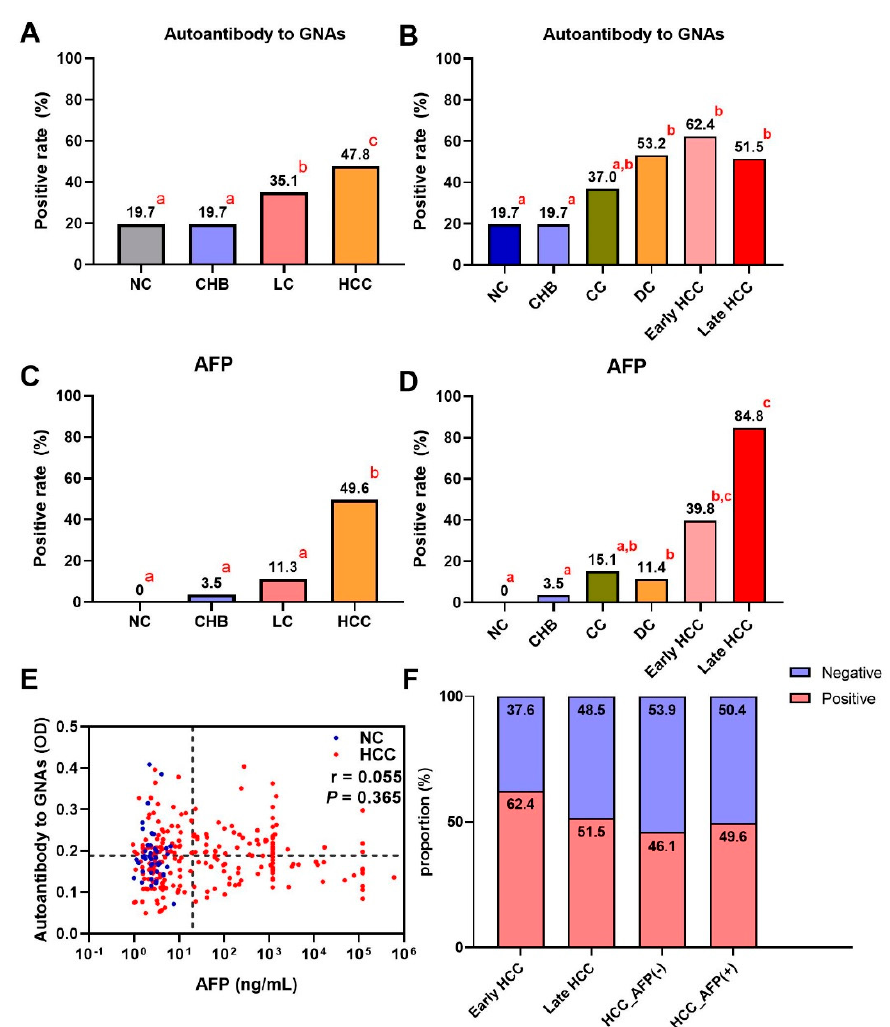
Figure 4. The bar charts of positive rates of autoantibody to GNAS and AFP in different groups of the development of HCC ( A – D ) in the validation phase. If the letters in the upper right corner (a, b, c) between two bars are totally different, the difference between the two groups is considered to be significant ( p < 0.05). ( E ) The relationship of AFP and autoantibody to GNAS, and ( F ) the distribution of positive rate and negative rate in subgroups of HCC. HCC: hepatocellular carcinoma; NC: normal control; LC: liver cirrhosis; CHB: chronic hepatitis B; CC: compensated liver cirrhosis; DC: decompensated liver cirrhosis; AFP: alpha-fetoprotein. The r in ( E ) is the correlation coefficient.